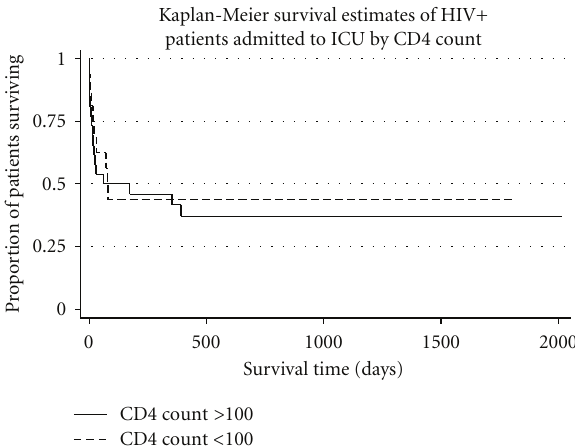
Figure 1: Survival of HIV+ patients admitted to ICU by CD4 count category greater or less than 100. P = 0 . 56 by log rank test. Analysis using a CD4 cut-o ff of 200 or 50 gave a similar